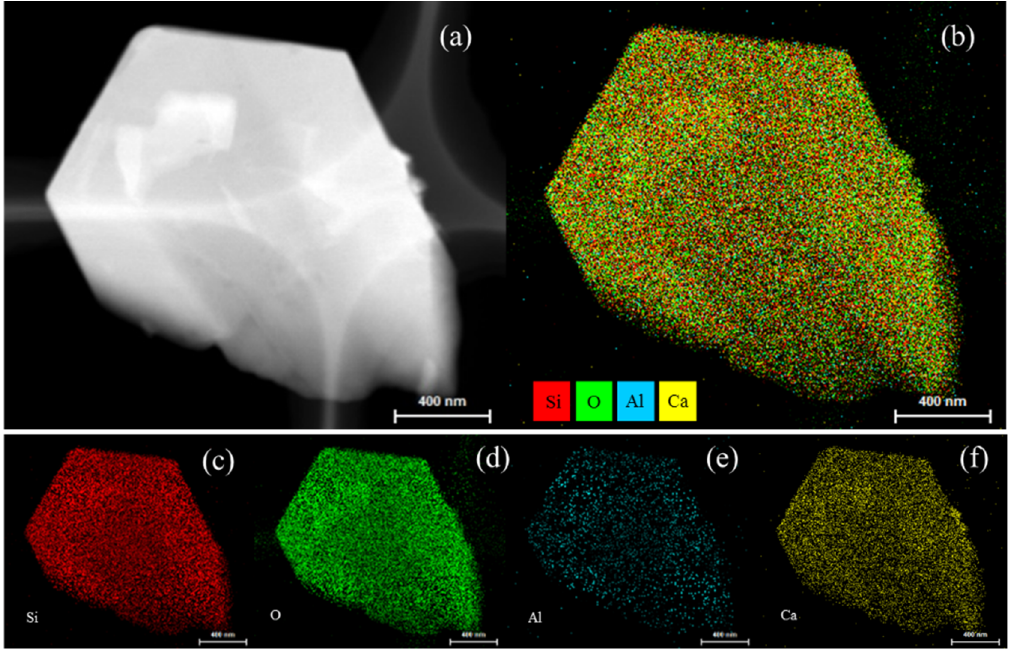
Figure 4. ( a ) High-angle annular dark-field scanning transmission electron microscope (HAADF- STEM) image, ( b ) STEM-EDS layered image, and ( c – f ) STEM-EDS map for Si, O, Al and Ca of the 10%CaO/HZSM-5(38) catalyst. Table 2. Density of B and L acid sites in the 10%CaO/HZSM-5, CaO and HZSM-5 samples of pyridine, as determined by